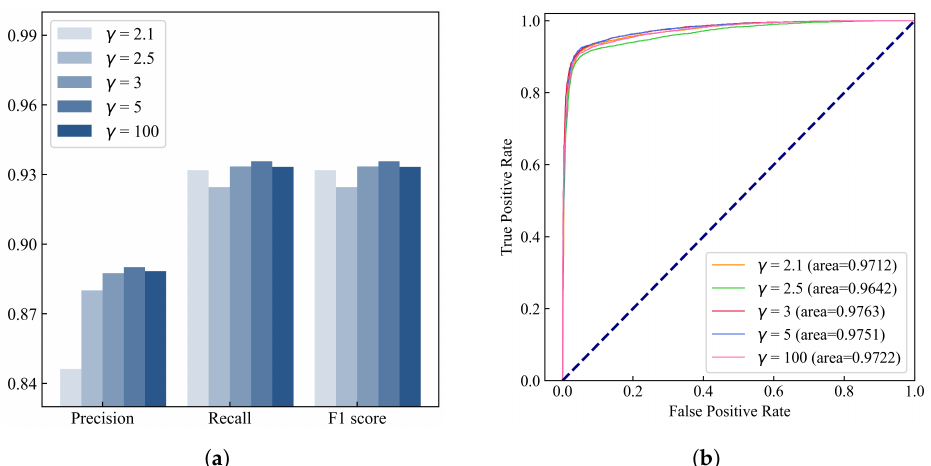
Figure 6. LPSMN performance among different degree distribution networks. ( a ) Recall, preci- sion and F1 score among different degree distribution networks; ( b ) AUC among different degree distribution